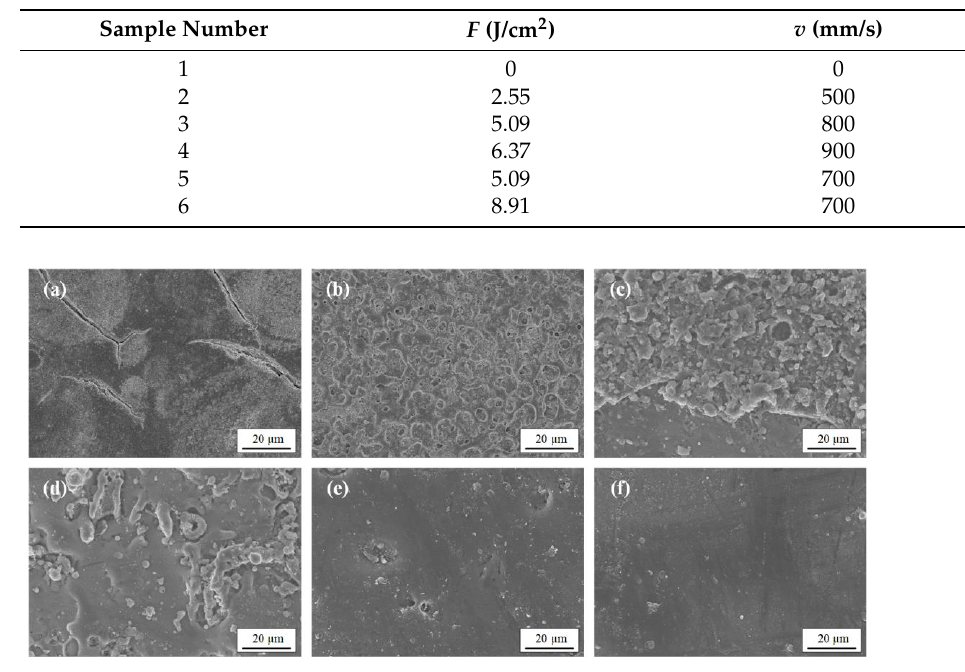
Figure 4. Micromorphology of aircraft skin surfaces before and after laser cleaning: ( a ) untreated sample 1 and laser-cleaned ( b ) sample 2, ( c ) sample 3, ( d ) sample 4, ( e ) sample 5, and ( f ) sample 6.